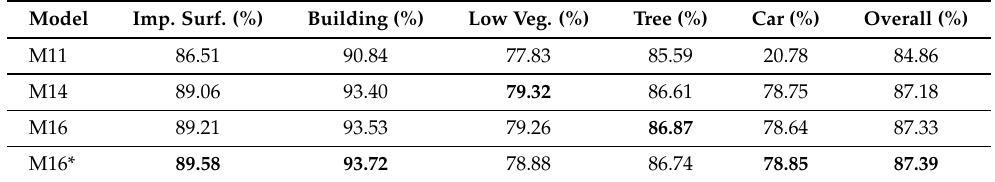
Table 10. Test scores obtained using Vaihingen dataset for dual-stream segmentation models. All quality measures except for overall accuracy are F1 scores in